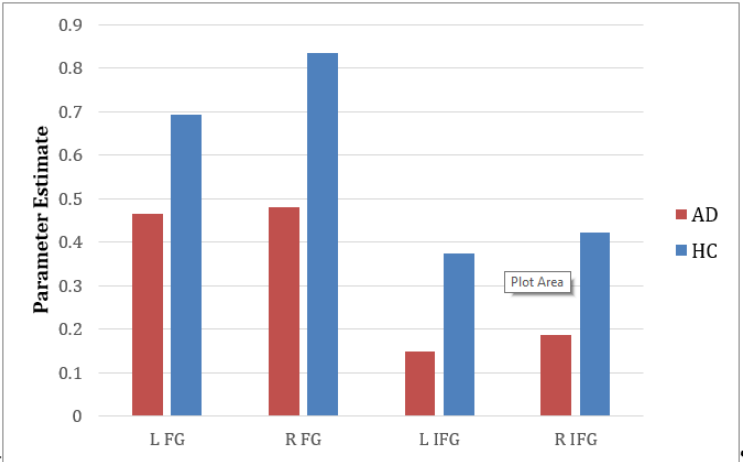
Figure 6. Comparison of parameter estimates between left and right hemispheres. L FG = left fusiform gyrus, R FG = right fusiform gyrus, L IFG = left inferior frontal gyrus, R IFG = right inferior frontal